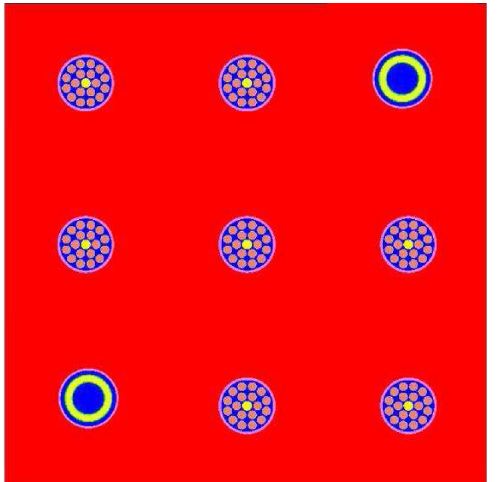
Fig. 2. Unit representative of the core.